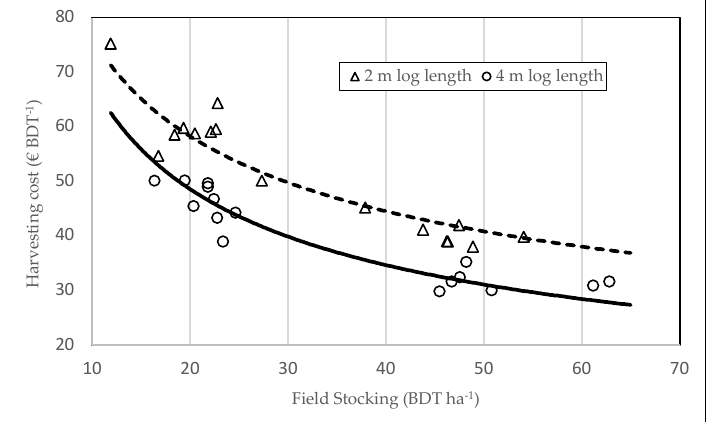
Figure 2. Relationship between total harvesting cost and field stocking.